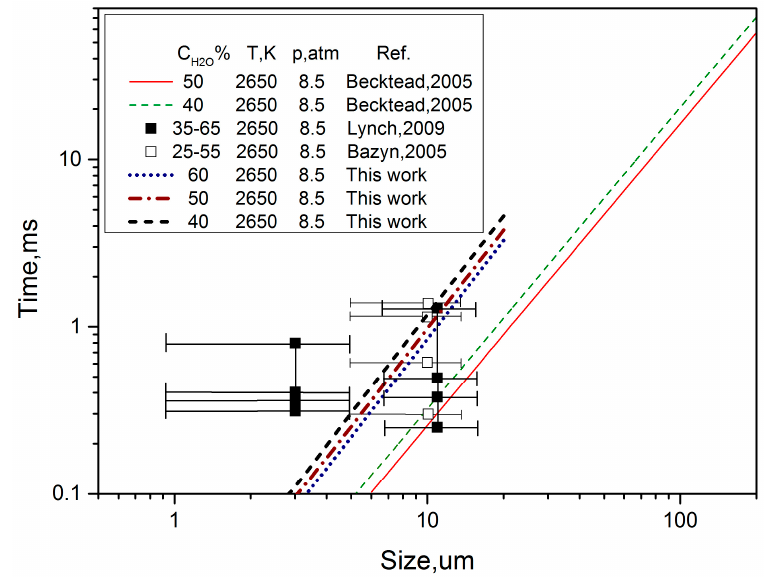
Figure 4. Combustion time as a function of particle size for Al particles.